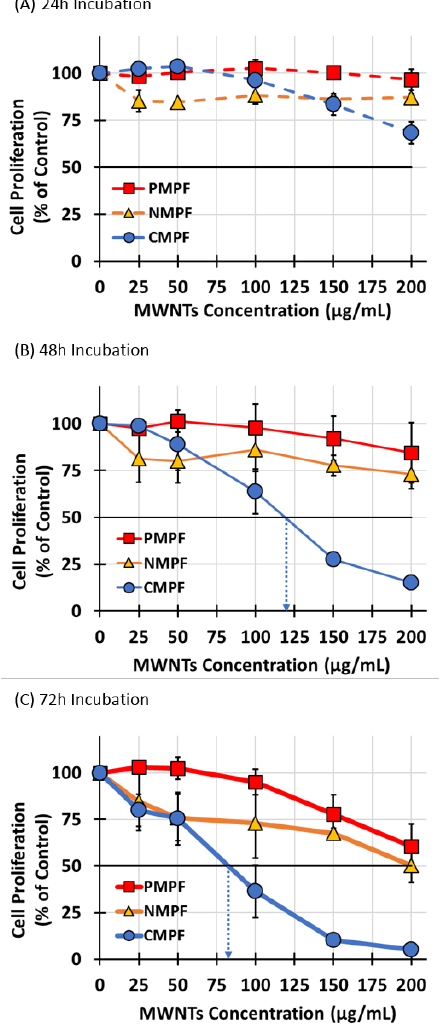
Figure 3. Effects of P-, N-, and C-MWNTs dose and exposure time on RAW 264.7 cell proliferation. RAW 264.7 cells in 48-well plates were incubated in media containing 25, 50, 100, 150, or 200 µg/mL of P-, N-, or C-MWNTs at 37 °C. Cells incubated in regular culture medium in the absence of MWNTs was the untreated control. IC50 values were estimated from a linear regression dose-effect trend line as the concentration of MWNTs needed to inhibit cell proliferation by 50%. Cell proliferation after a ( A ) 24 h, ( B ) 48 h, or ( C ) 72 h exposure to MWNTs was determined by the crystal violet assay where the proliferation of control cells was set to 100%. Dotted arrows indicate estimated IC50 values of 120 and 80 µg/mL for cells treated with C-MWNTs for 48 and 72 h, respectively. Data are the average of quadruplicate measurements per sample in ≥3 independent experiments ± SEM.